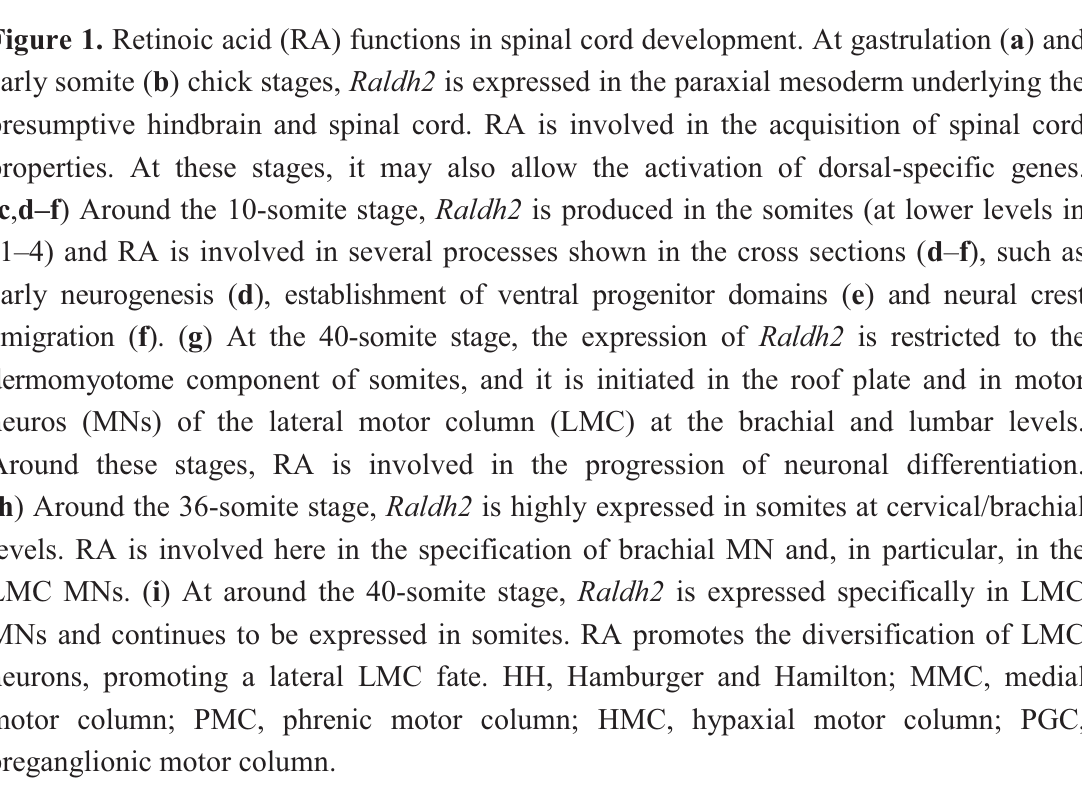
Figure 1. Retinoic acid (RA) functions in spinal cord development. At gastrulation ( a )